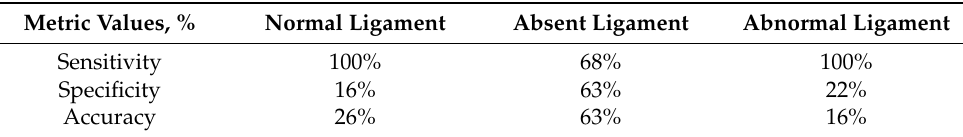
Table 2. MRI sensitivity, specificity, and accuracy for the diagnosis of CAI in three different situations: normal, abnormal, or absent ligament. In the normal ligament scenario, only a normal ATFL is considered a stable ankle and the MRI is negative for CAI, in the absent ligament scenario only absence is considered positive for CAI. In the abnormal ligament scenario, absent ligament cases were excluded and any other abnormality on ATFL was considered positive for